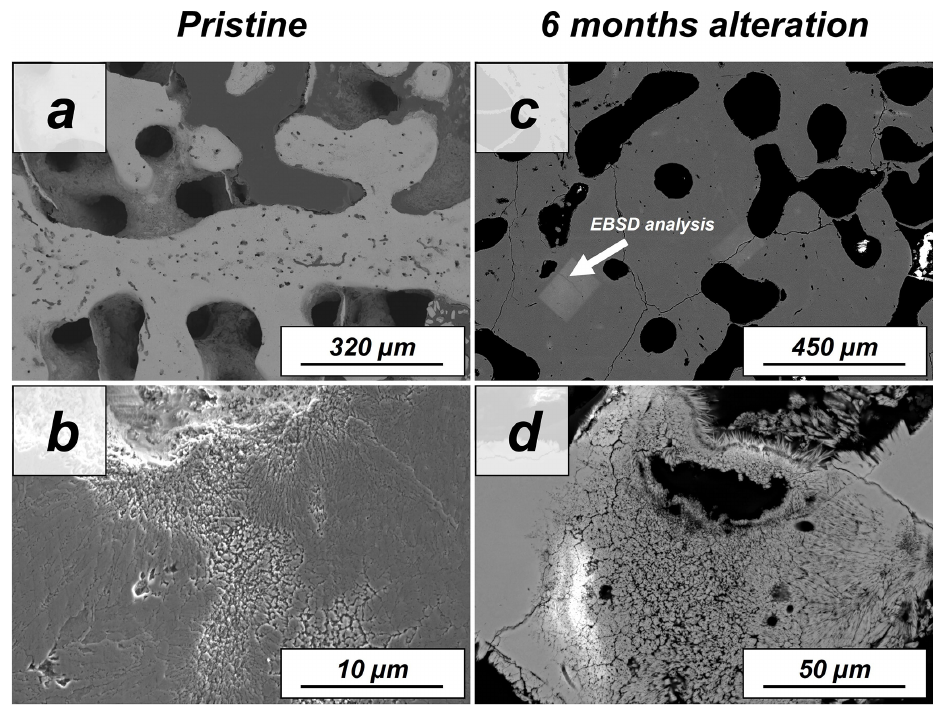
Figure A12. SEM images showing the (a, b) pristine and (c, d) altered skeletons of the coral Porites sp. The stony skeleton of Porites sp. has abundant intrinsic porosity within the mineralized units. The aragonite grows as fibrils outward from the centres of calcification. (c, d) The aragonitic microstructure of the coral Porites sp. is extremely resistant and undergoes no major changes upon hydrothermal alteration with a burial-mimicking fluid for 6 months at 80 ◦ C according to SEM images.